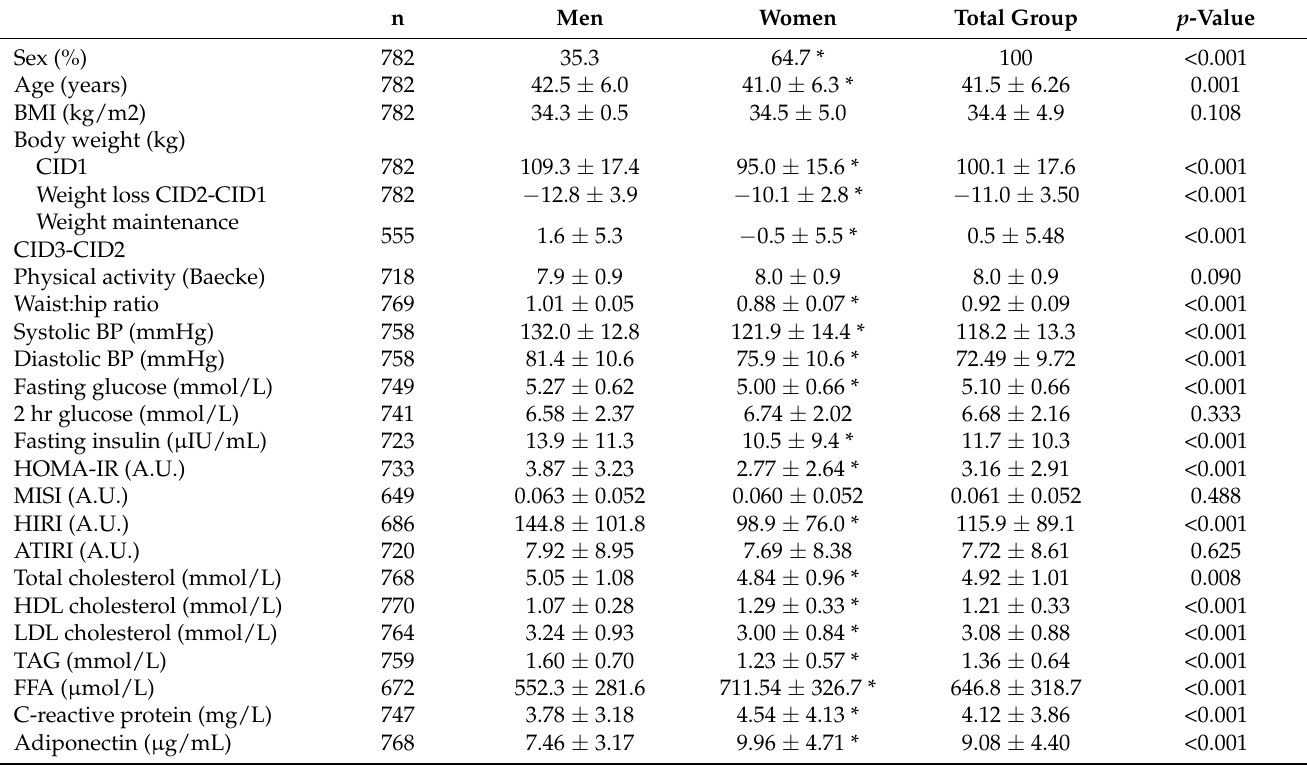
Table 1. Participant